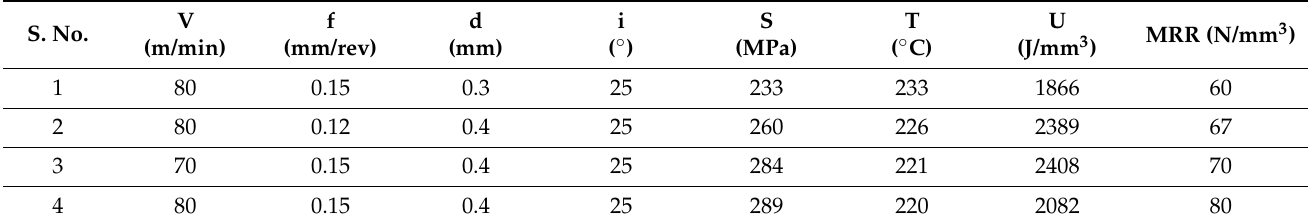
Table 6. Details of optimal solutions.